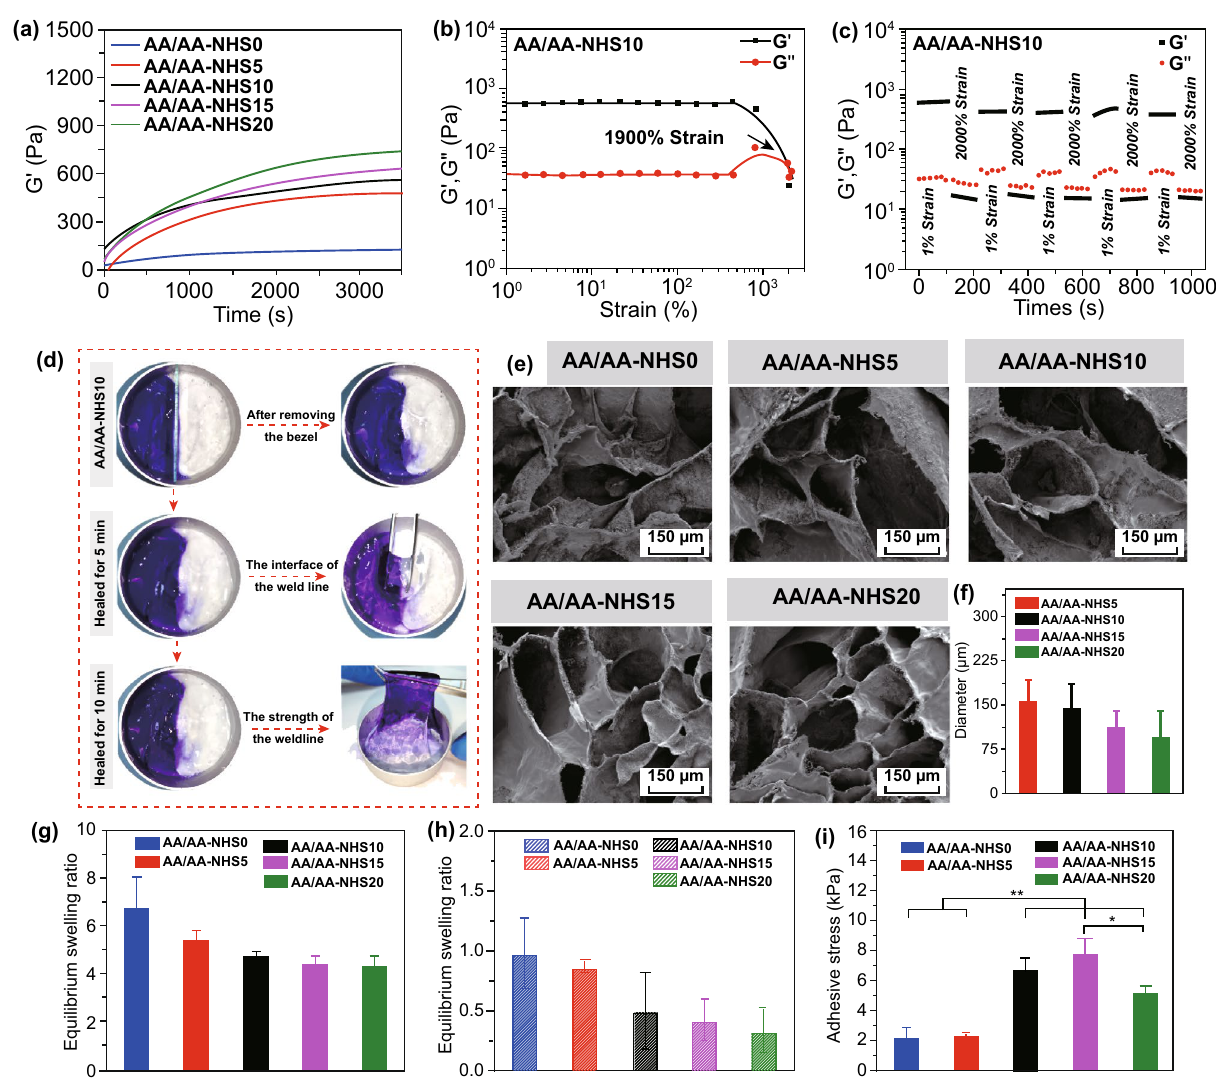
Fig. 2 a Rheological behavior of AA/AA-NHS hydrogels. b G ʹ and G ʺ of the AA/AA-NHS10 hydrogel in the strain sweep test. c The rheologi- cal properties of the AA/AA-NHS10 hydrogels when the alternate step strain was switched from 1 to 2000%. d The macroscopic self-healing test of the AA/AA-NHS10 hydrogel. The hydrogel on the left was stained with crystal violet. e SEM images and f the pore size of the AA/AA- NHS hydrogels. Swelling behavior of AA/AA-NHS hydrogels at pH values of g 7.4 and h 2.0. i Adhesive strength of the AA/AA-NHS hydro- gels on the substrates of the porcine stomach. * P < 0.05, ** P <